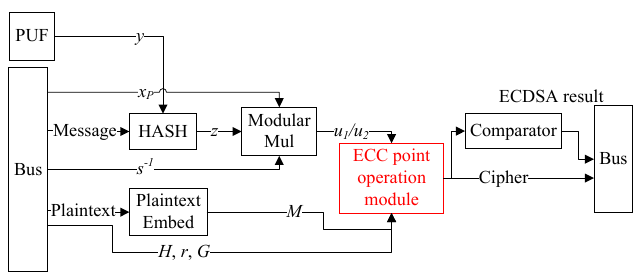
Figure 17. custom ECDSA and ECDH data flow.